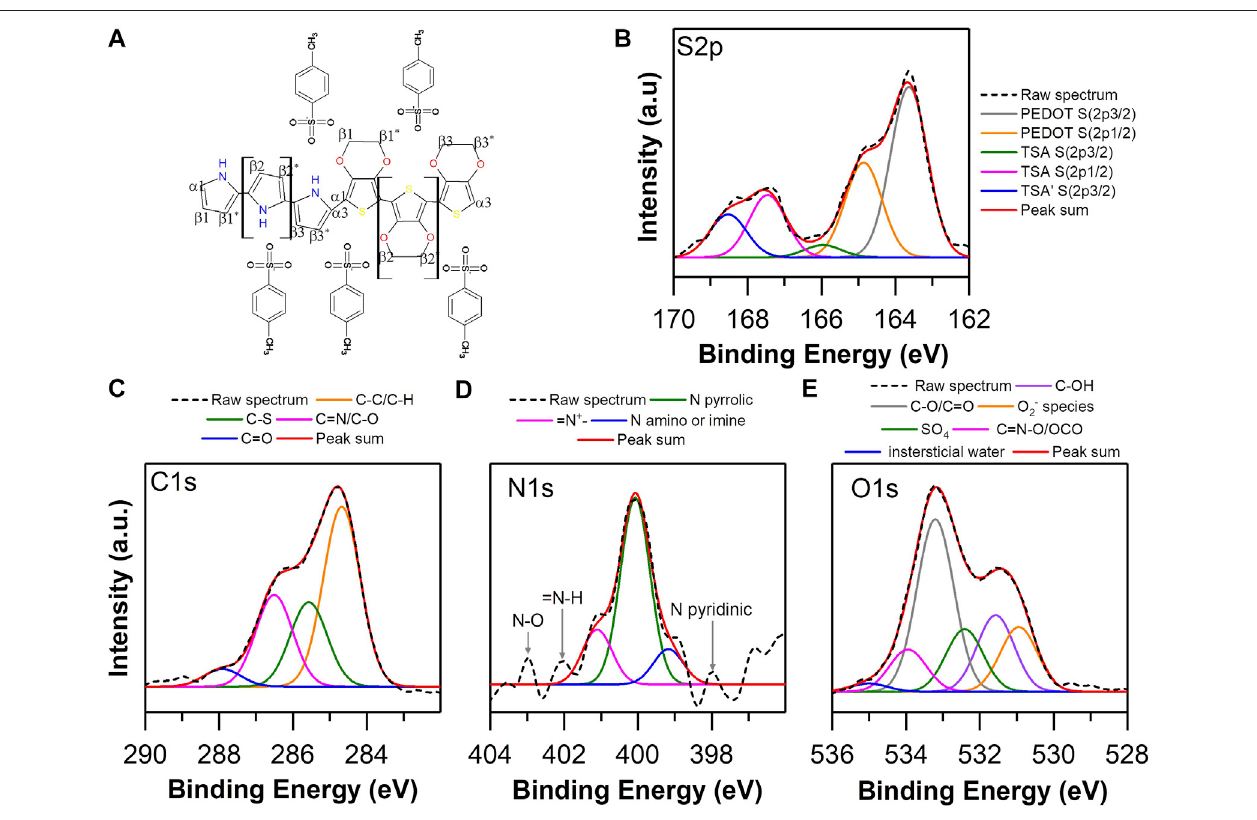
FIGURE 8 | (A) Proposed structure of EDOT-PY TSA Copolymer, High Resolution XPS Spectra of EDOT-PY 0.7 – 0.3 TSA: (B) S 2p, (C) C 1S, (D) N 1s and (E) O 1s.